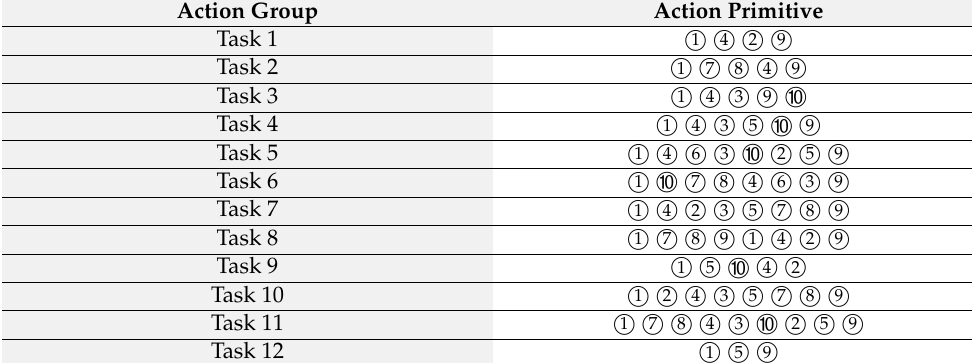
Table 5. Composition of action primitives in action groups.